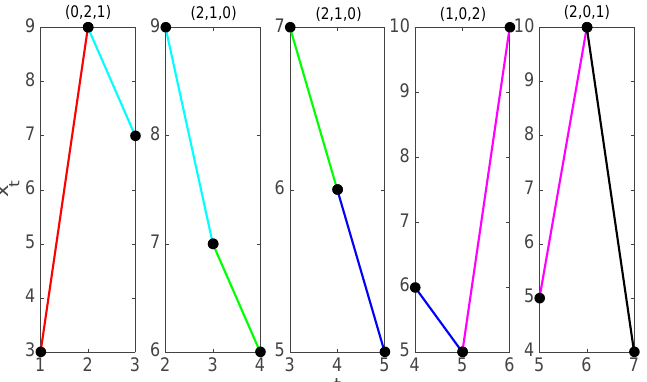
Figure 1. Symbolization of the time series of seven values given by (1) for m = 3. From left to right we find the five 3-histories that can be constructed and their associated symbol.